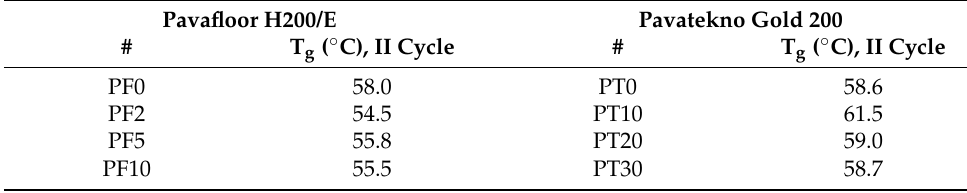
Table 6. Glass transition temperatures obtained with DSC for each